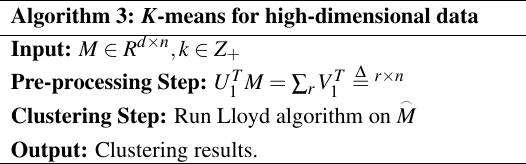
Figure 3. The K -means clustering algorithm of for high-dimensional